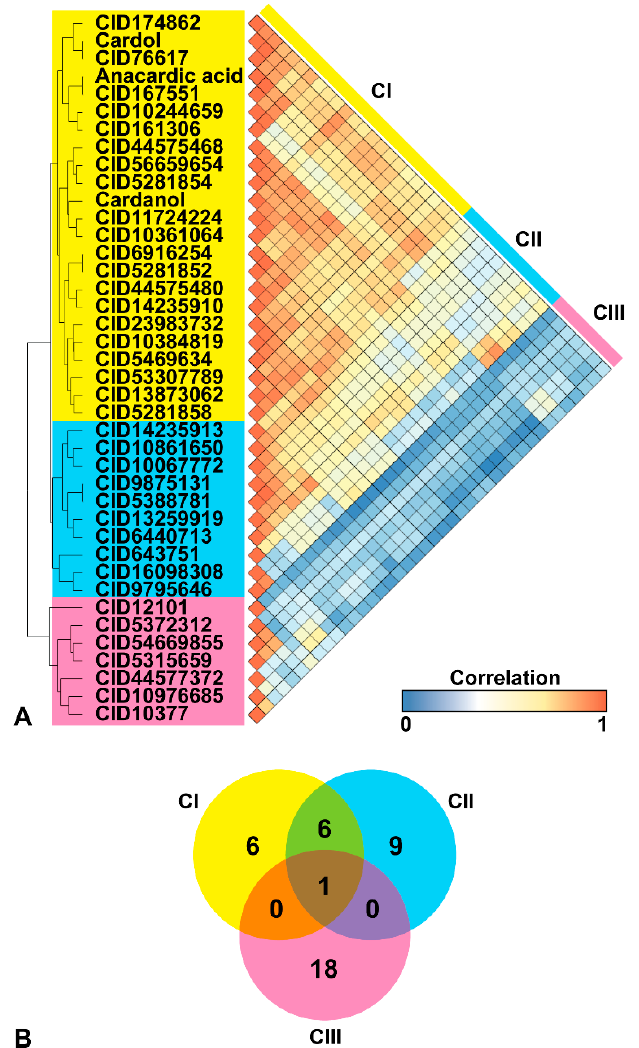
Figure 2. ( A ) Three clusters of phenolic lipids and active similar compounds; CI, CII, and CIII, represented as a hierarchical dendrogram (yellow, blue, and pink). The similarity score of these compounds is illustrated as a heatmap correlation that ranged from 0 (blue) to 1 (orange). ( B ) The overlap of targets from the bioassay database for the 37 active similar compounds. Only one target was a common protein of all similar